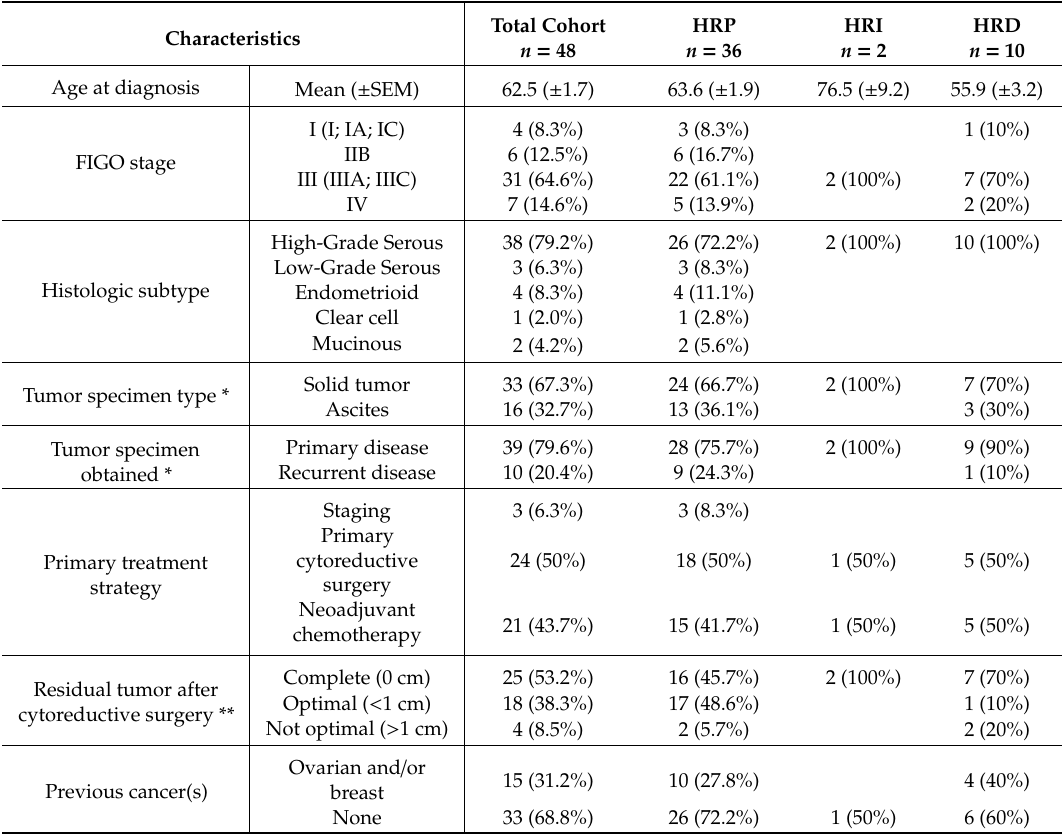
Table 1. Clinicopathological characteristics stratified for homologous recombination capacity of the tumor.